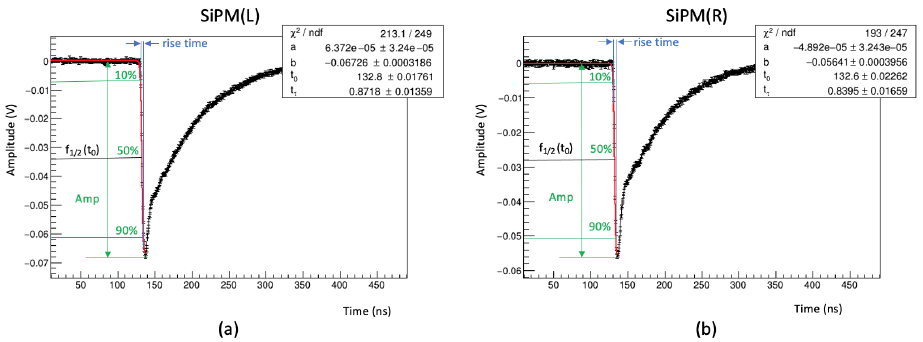
Figure 6. Fast pulse signals induced by the 90 Sr source and recorded by both SiPMs: ( a ) left SiPM(L) and ( b ) right SiPM(R). The fit result (red lines) on the fast leading edge of the signals, the rise time and the time at half maximum of the pulse height, t 0 , are also